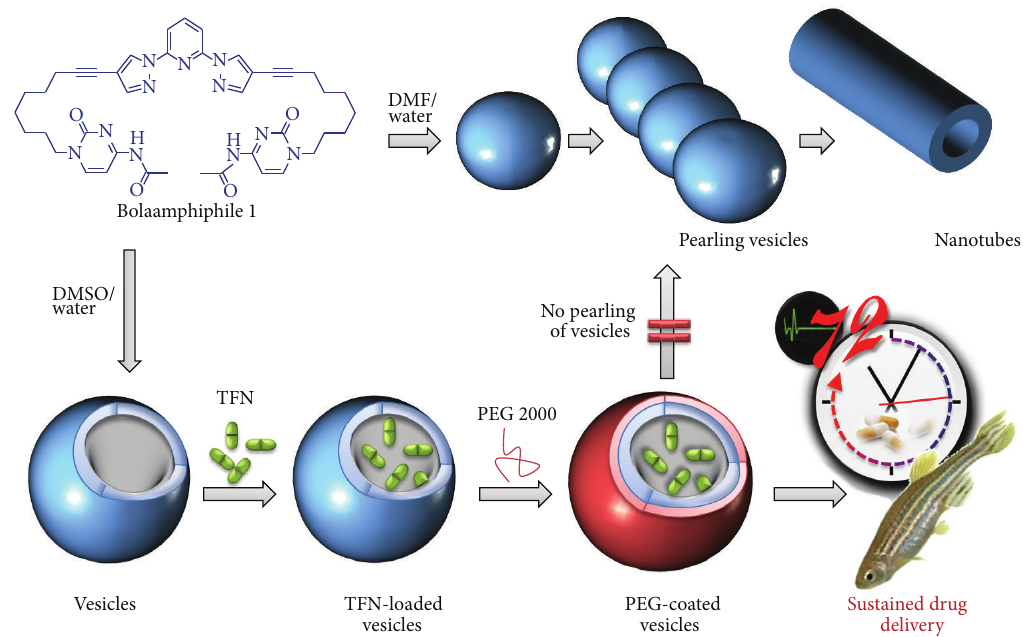
Figure 1: Illustration of the nanovesicles formation from bolaamphiphile 1 and their subsequent self-assembly into pearl chains and finally nanotubes. The nontoxic vesicles fusion (pearling) is prevented by biocompatible polymer coating and used in terfenadine (TFN) drug delivery in a sustained manner (72 h) in zebrafish model